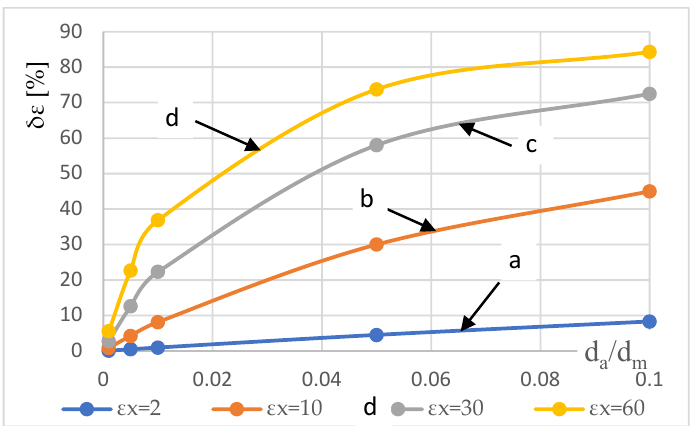
d for MUT permittivity: (a) ε x = 2, (b) ε x = 10, for MUT permittivity: (a) 2 d m d m